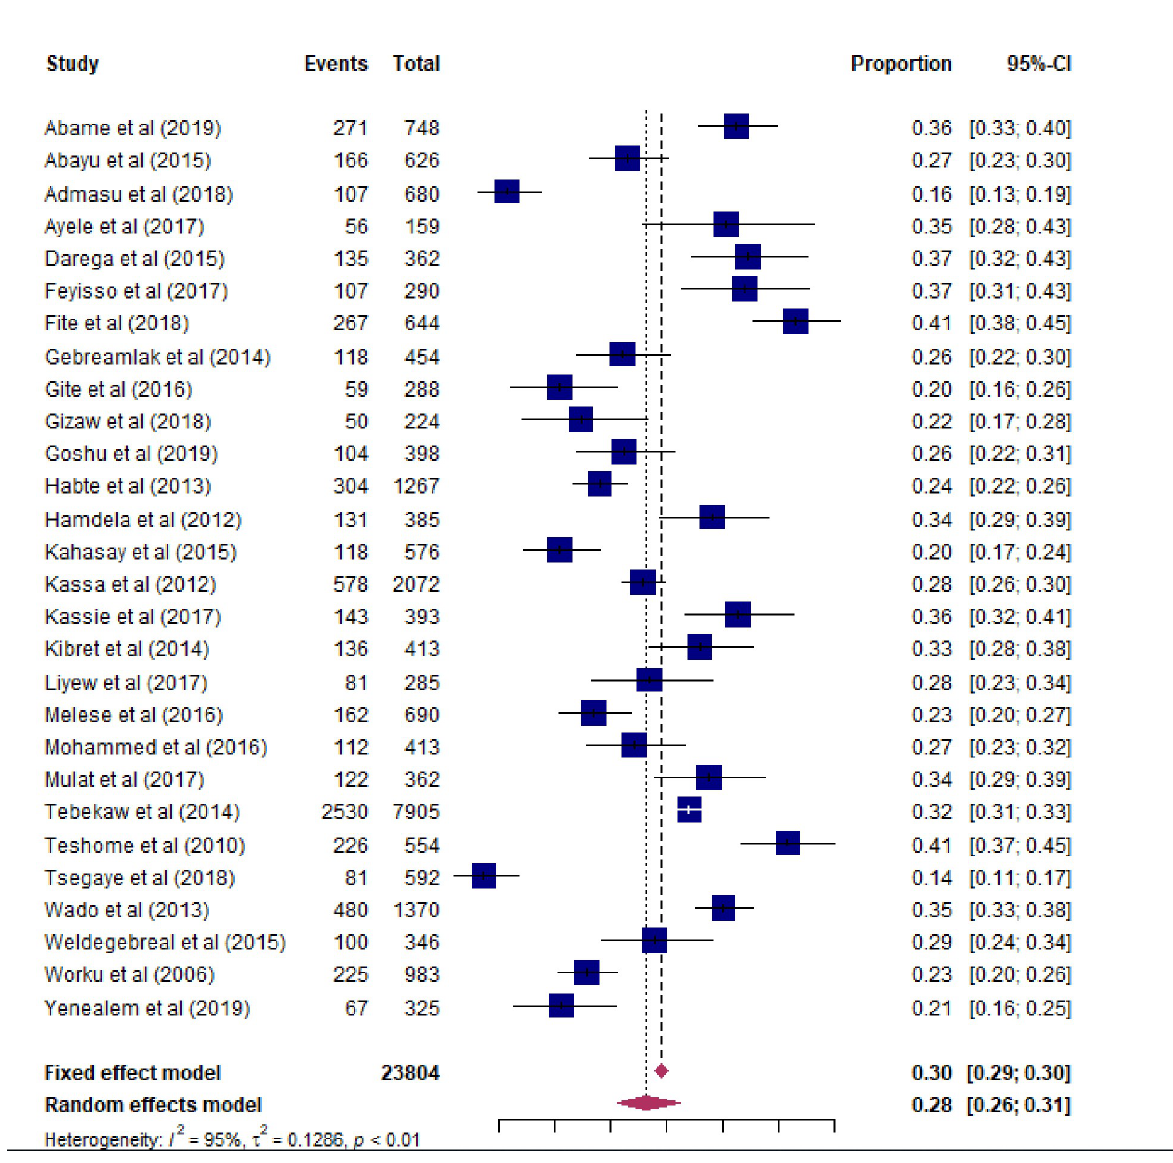
Fig 2. Forest plot of the pooled prevalence of unintended pregnancy in